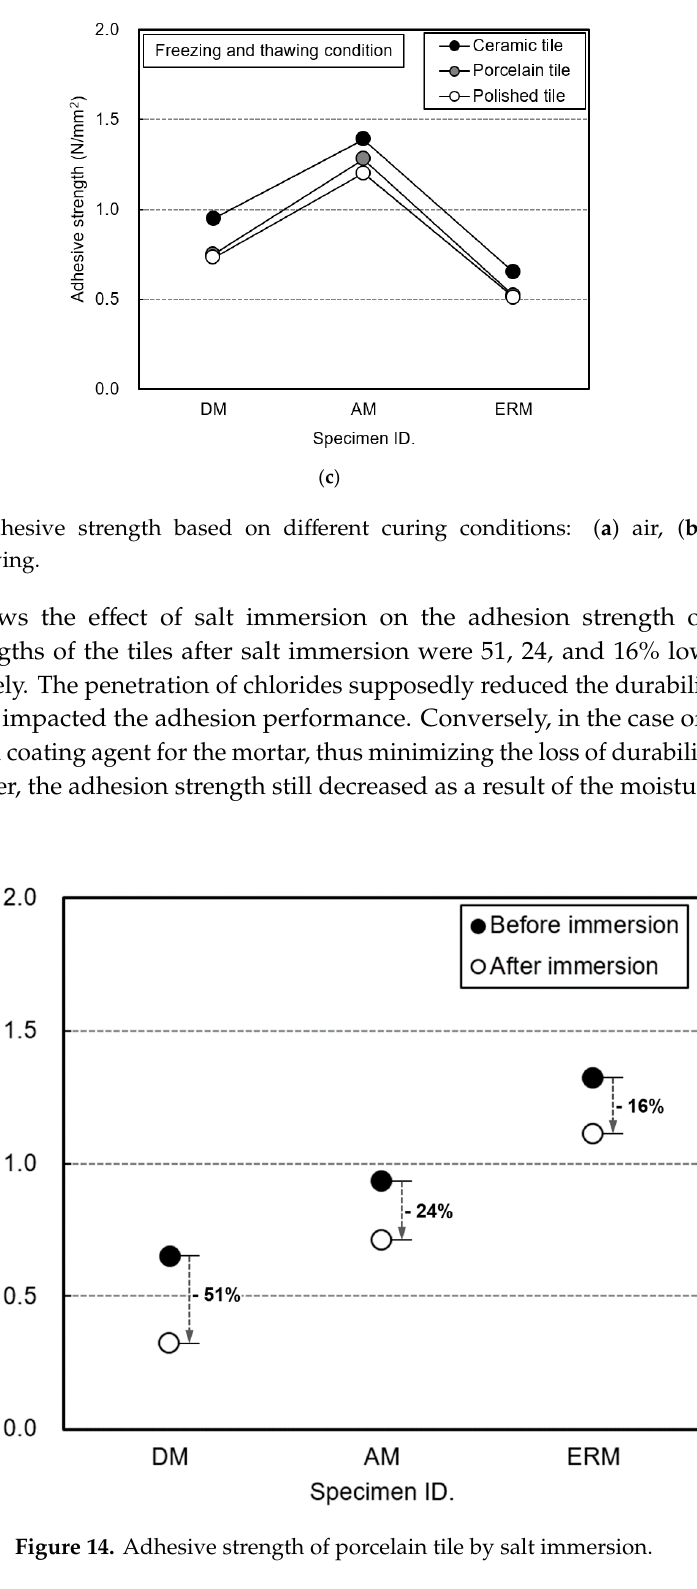
Figure 15. Adhesive strength of the porcelain tiles based on the laitance of concrete.